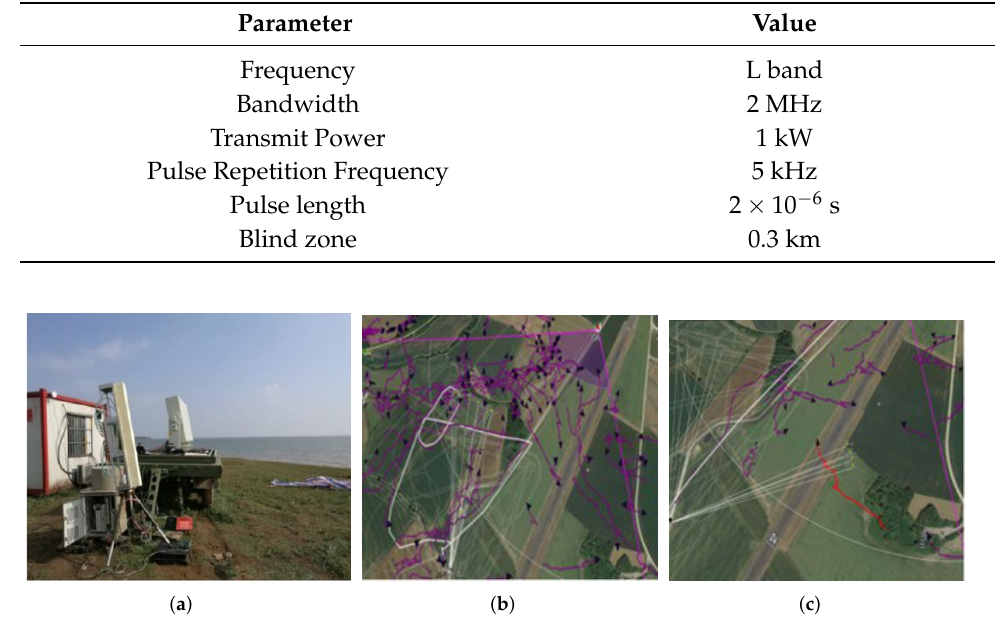
Table 1. Operating parameters of staring radar.